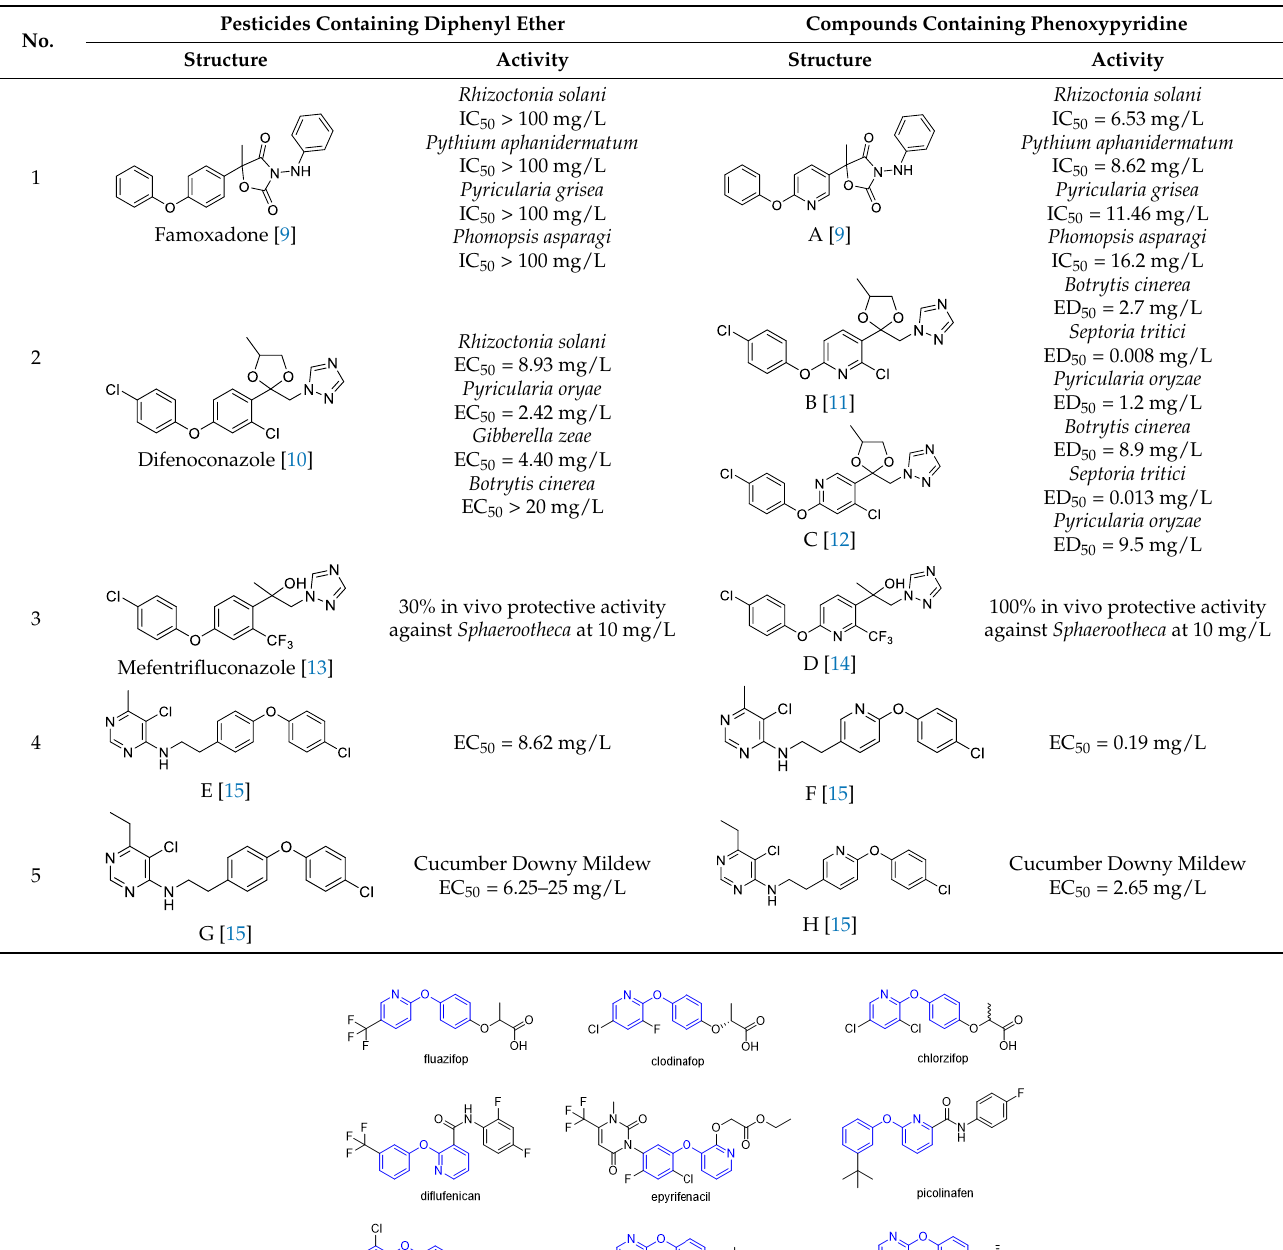
Table 1. Comparison of the activity of diphenyl ethers and phenoxypyridine pesticides.